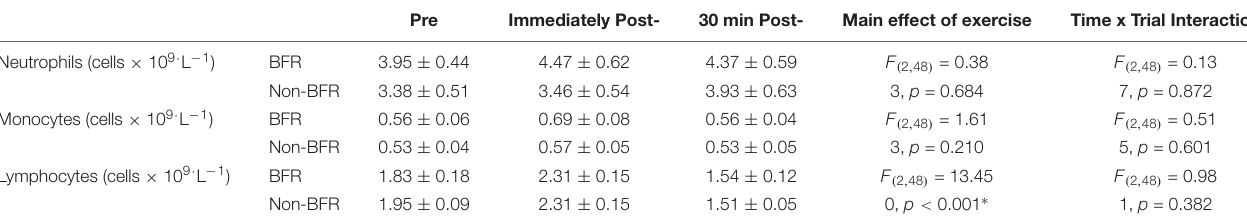
Values shown are mean ± SEM, ∗ p <